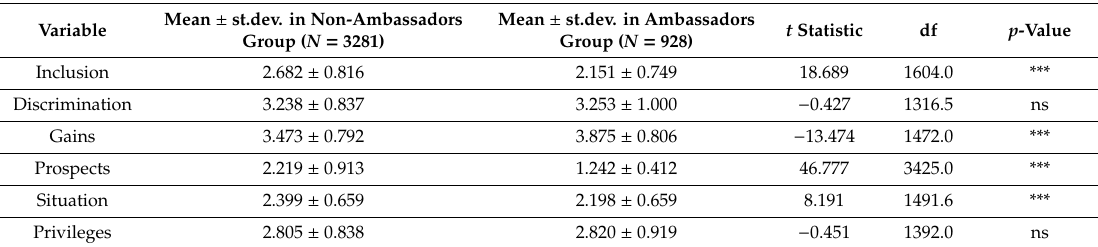
Table 8. Results of comparison—groups of ambassadors and